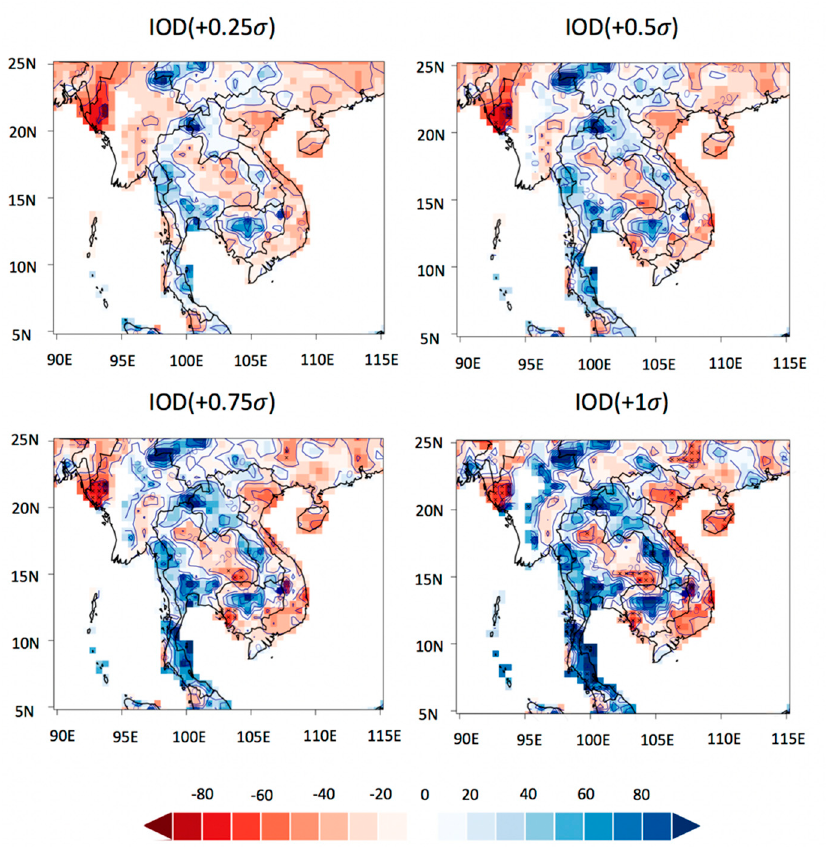
Figure 4. Percentage changes in extreme drought over the Indochina Peninsula (departures from the 1981–2010 norms). The climatology mean of IOD (1981–2010) was deliberately increased by 0.25 σ through IBB simulations to analyze the sensitivity of extreme drought to the warming phase of IOD in the tropical Indian Ocean. In each figure, the median results derived from 1000 simulations are shown and the statistically significant area of change at 95% significance level is represented by “x”.